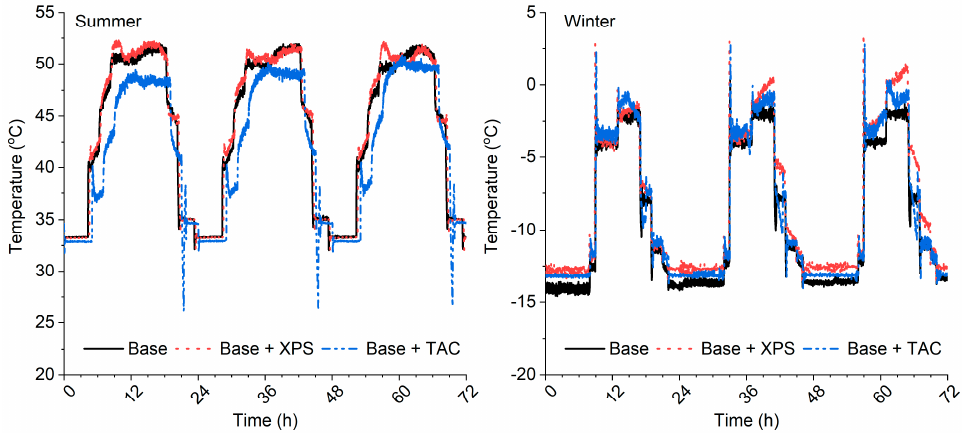
Figure 7. Air temperature in the climate chamber.